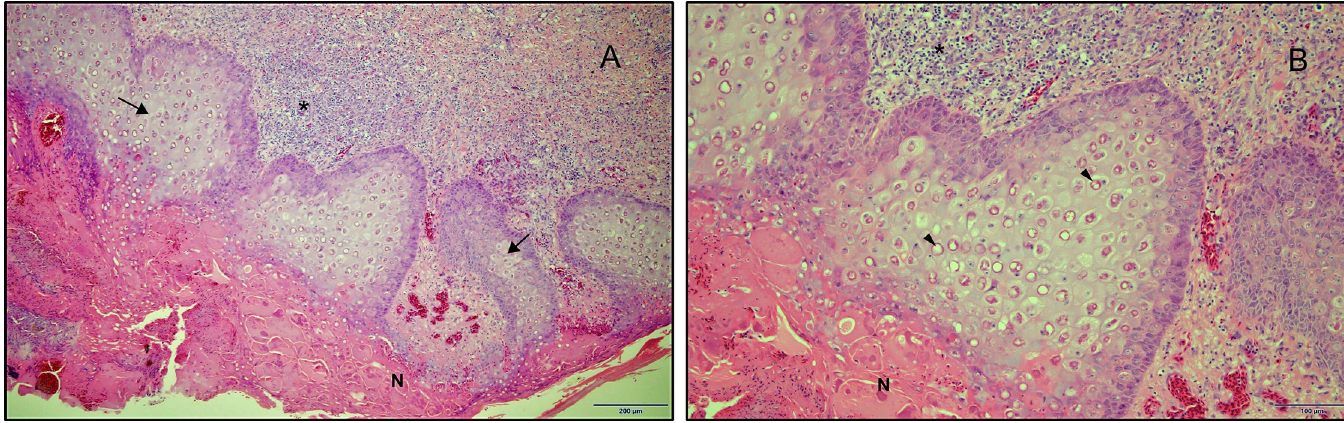
Fig 1. Low (A) and high (B) magnification histopathological images of FPV field isolate from comb tissue showing erosion of the epithelial lining in association with necrotic cell debris (N) oedema and mononuclear inflammatory cell infiltration into the dermis ( � ), hyperplasia and ballooning of the epithelial cells (arrows in A) and round intracytoplasmic eosinophilic inclusion bodies in some of the epithelial cells (arrowheads in B).